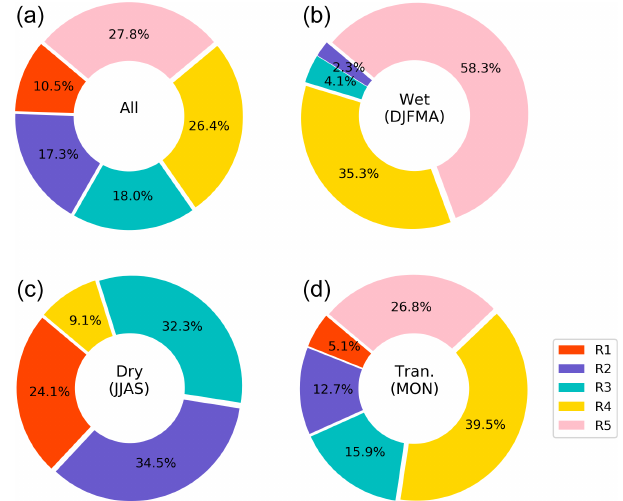
Figure 1. Breakdowns for the frequency to observe regime clus- ters (regimes 1 through 5 marked as R1 through R5) for the GoA- mazon2014/5 radiosonde dataset (12:00UTC), as well as break- downs for wet season (December, January, February, March, April), (May, October, November)